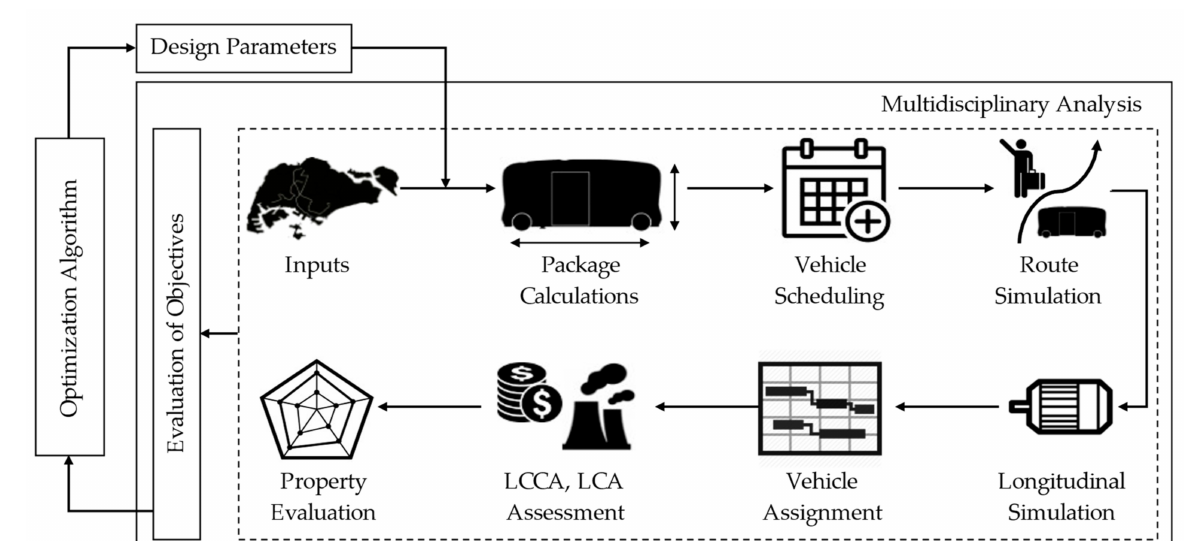
Figure 3. Overall simulation framework to evaluate the objective